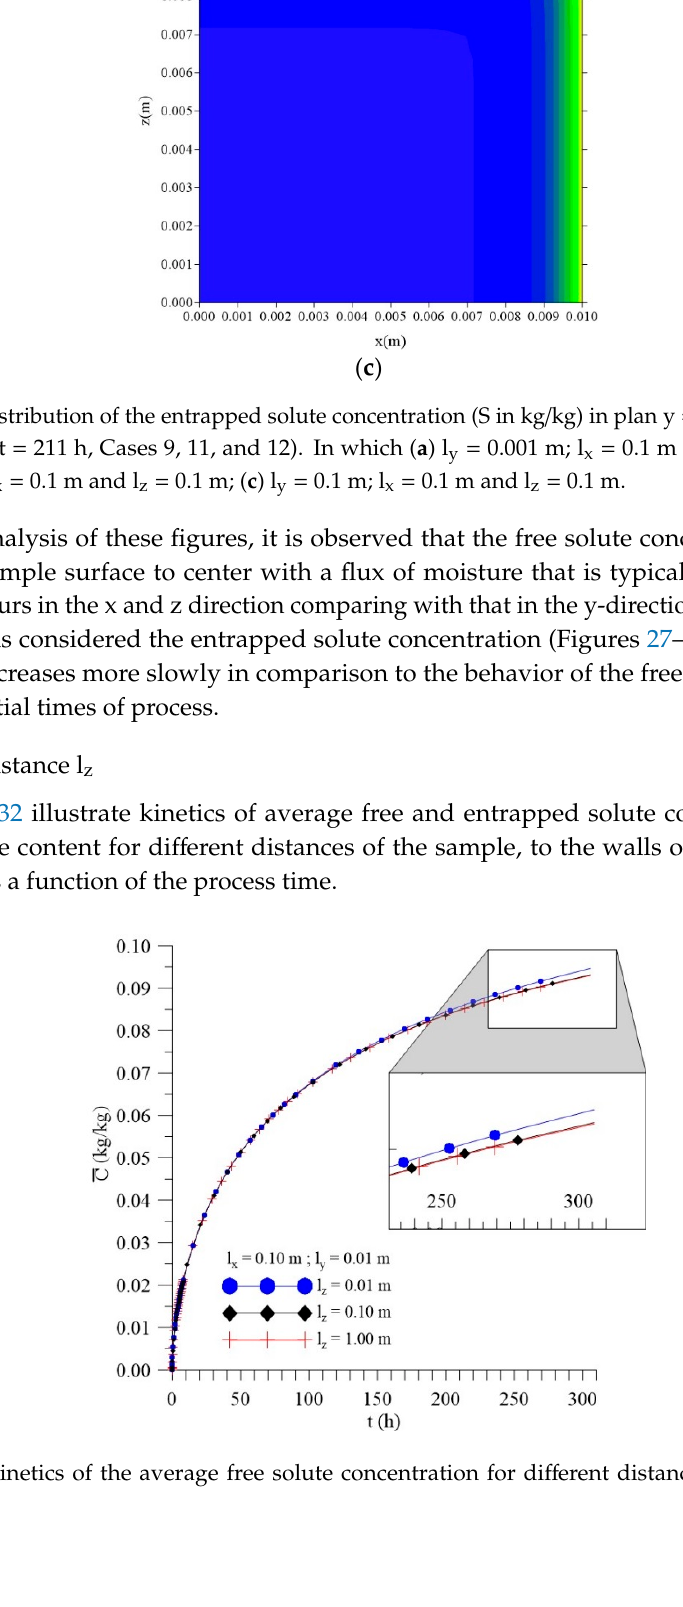
Figure 30. Kinetics of the average free solute concentration for different distances l z (Cases 9, 13, and 14).